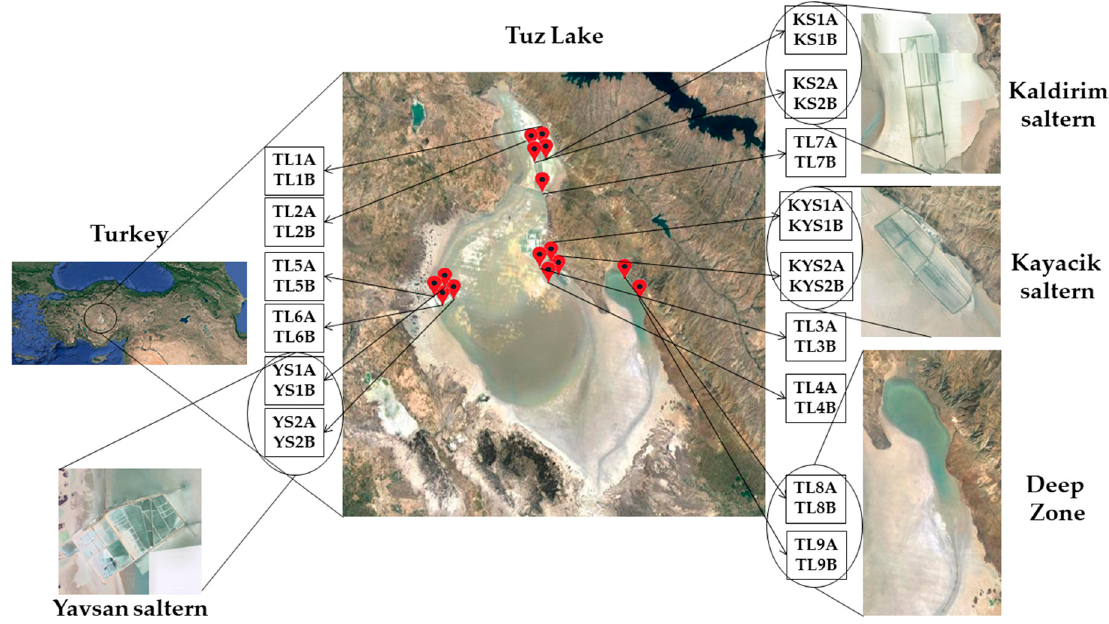
Figure 1. Locations of the sampling sites and 30 brine samples collected from Tuz Lake, Deep Zone, and Kayacik, Kaldirim, and Yavsan salterns in Turkey.